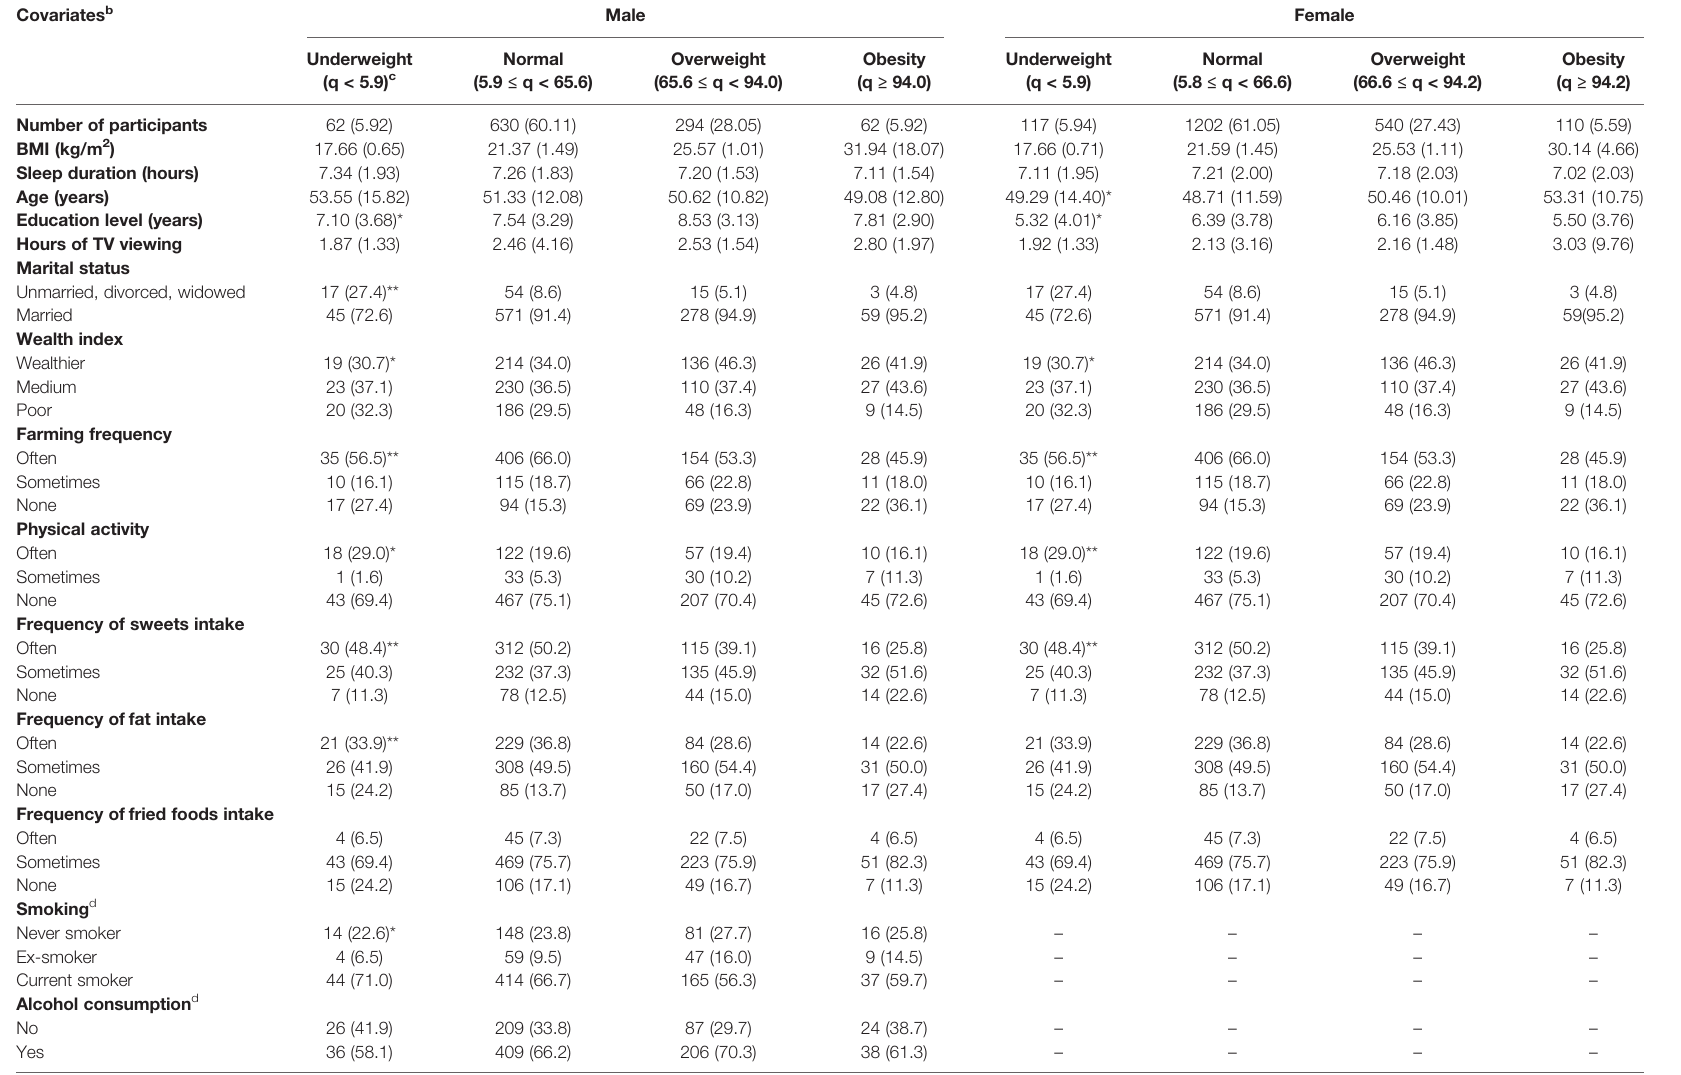
TABLE 1 | The characteristics of enrolled adult participants across different cutoffs of BMI by gender a